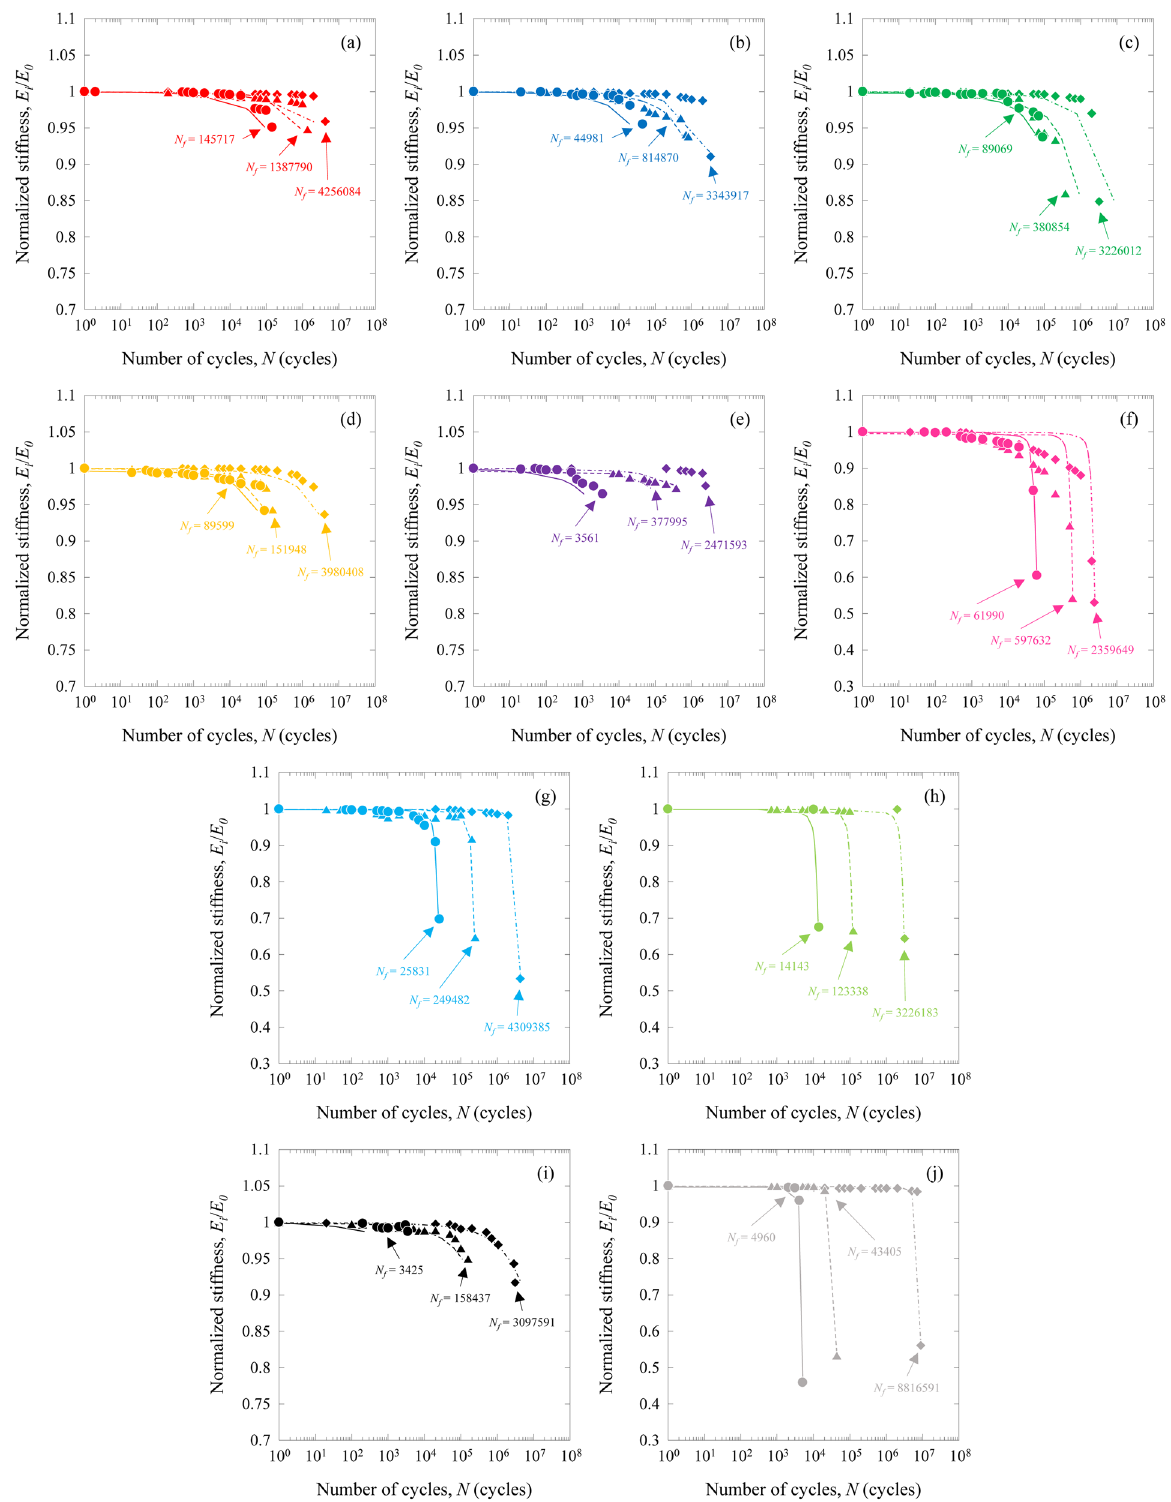
Figure 8. Stiffness reduction for the CFRP, GFRP, and HFRP specimens. ( a ) HA ([(0 (IMS60) )/(0 (E-glass) )] S ), ( b ) HB